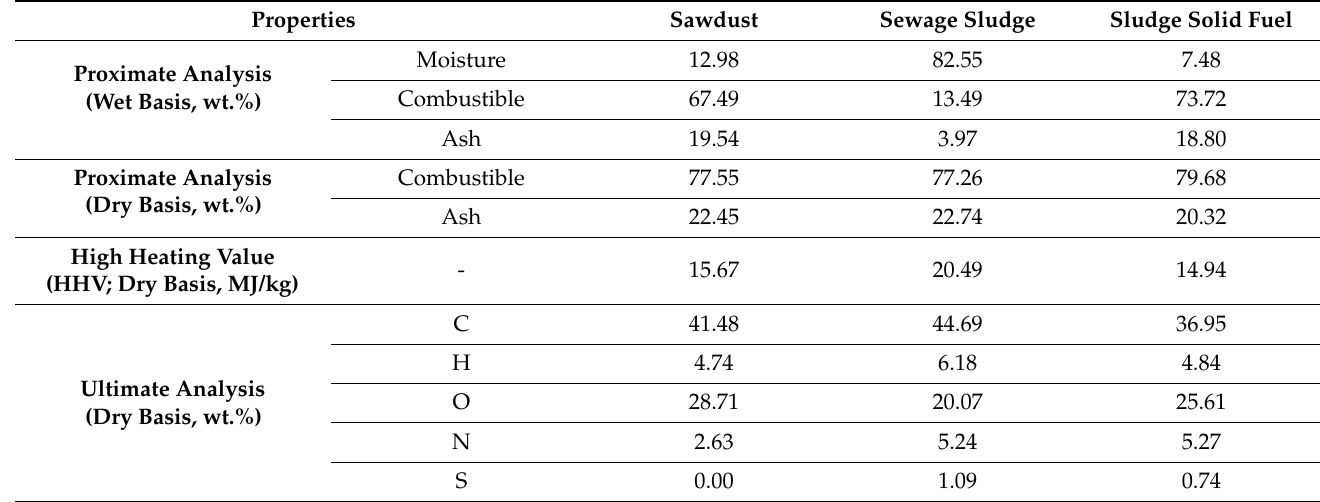
Table 3. Properties of sawdust, sewage sludge, and mixed solid fuel samples.